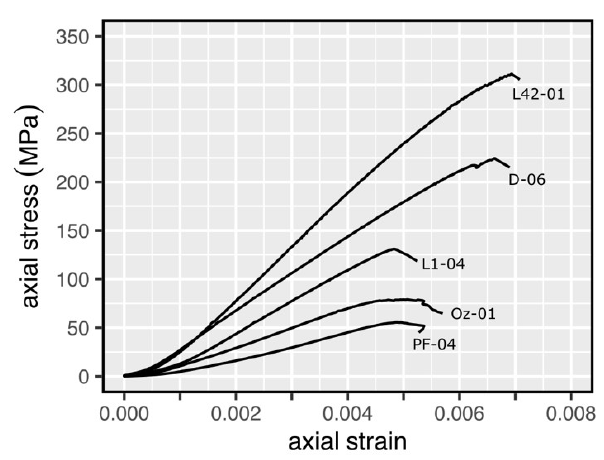
Figure 7: Representative uniaxial stress-strain curves for select samples of the basaltic rocks collected from La Réunion. Curves shown are for samples L401 (B05 micro-troctolite), D06 (D01 dyke), L104 (B02 lava), Oz01 (C01 olivine rich oceanite), and PF04 (E01 modern aphyric lava).